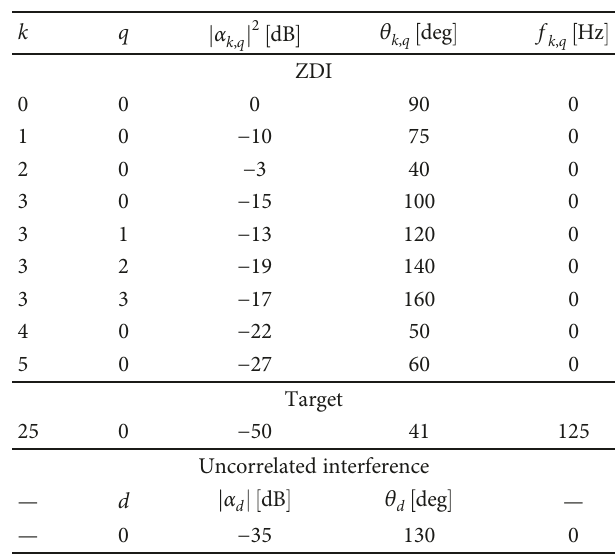
Figure 7: Application of STAC pre fi ltering technique. Table 1: Simulated signal